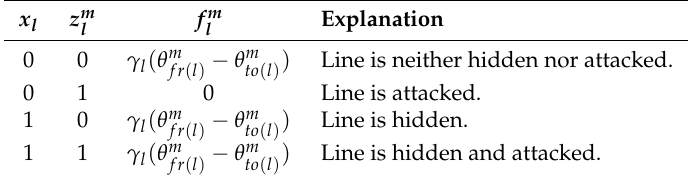
, x l , and z m for the optimal deception strategy problem. l l